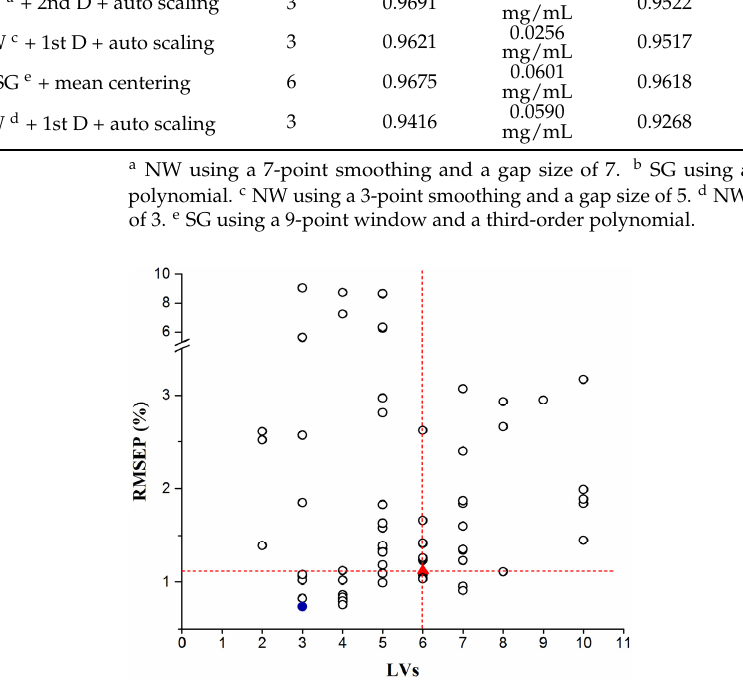
Figure 3. Overview of the TS content models for all pretreatment combinations. (The red triangle represents the model built from raw data, and the blue dot represents the final model built from the best pretreatments). Table 2. Overview of some commonly used algorithms for each pretreatment method.